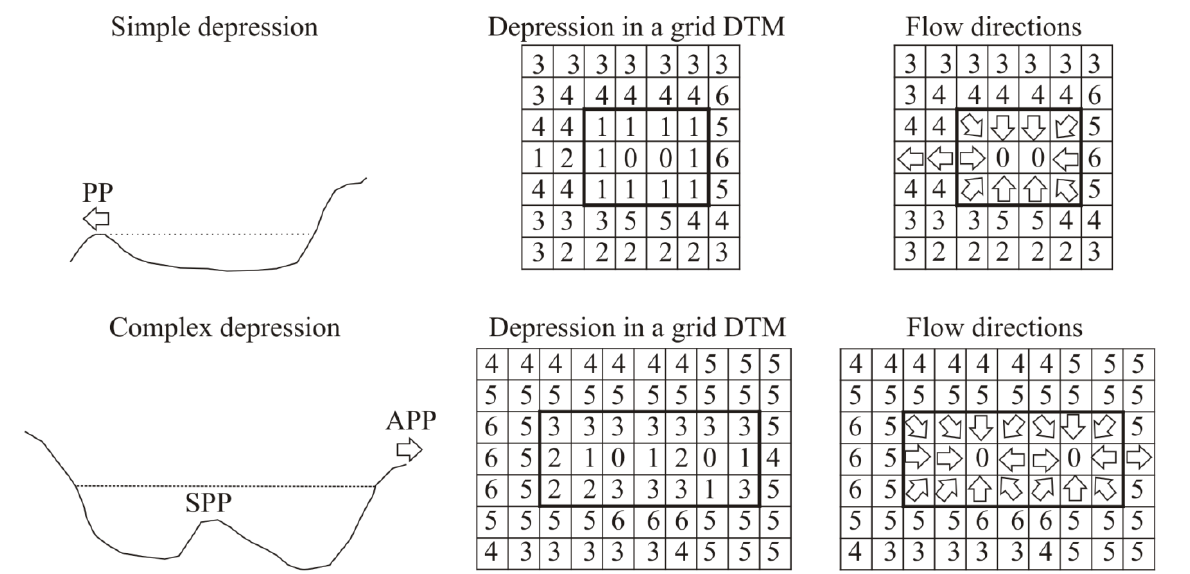
Figure 1. Topographic depressions in the field (left) and in a grid digital terrain model (DTM) (middle and right). Depressions can be simple or complex. Simple depressions have one pour point (PP) and complex ones have more than one pour point of which one is the actual pour point (APP) and the others are shared pour points (SPP)